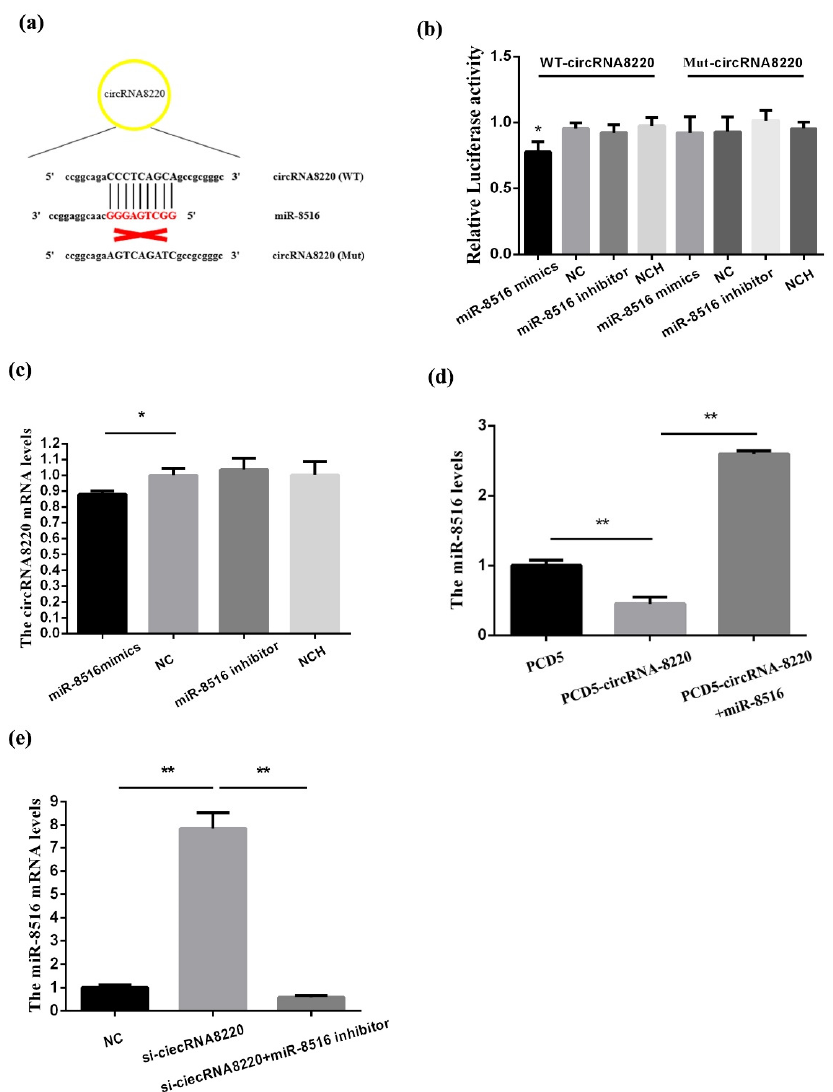
Figure 2. circRNA8220 acted as a sponge for miR-8516. ( a ) The seed sequence of miR-8516 could match with WT-circRNA8220 and could not match with Mut-circRNA8220. ( b ) Luciferase reporter assay of 293T cells co-transfected with wild type (WT)-circRNA8220 or Mut-circRNA8220 and miR-8516 mimic, NC (negative control), miR-8516 inhibitor or NCH (NC-inhibitor). ( c ) miRNA-8516 inhibited the mRNA expression of circRNA8220. ( d ) circRNA8220 decreased miR-8516 mRNA level in GMEC. ( e ) si-circRNA8220 promoted the mRNA expression of circRNA8220. ** p < 0.01, * p <